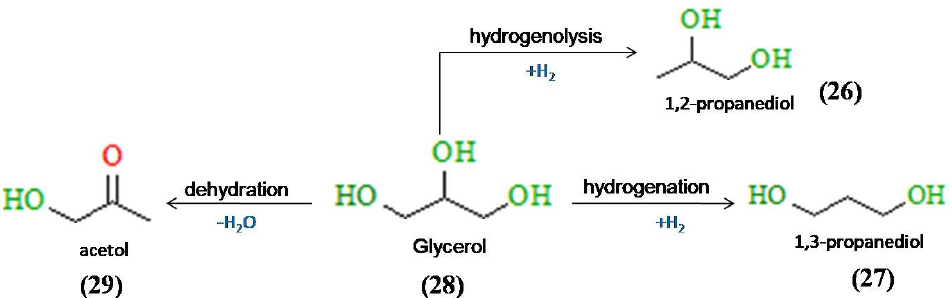
Figure 5. Reactions of the deoxygenation process.